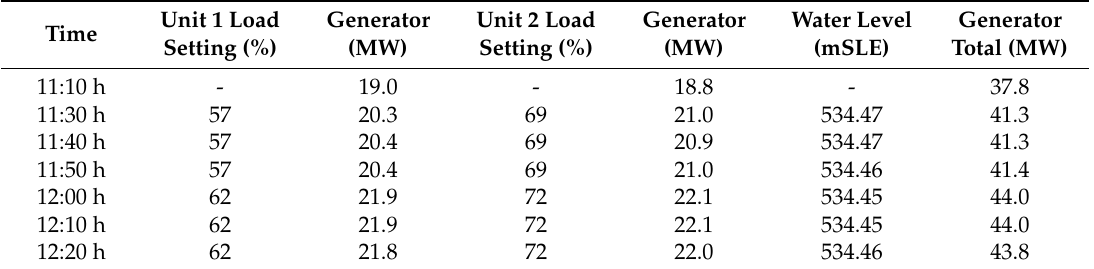
Table 4. Snapshots of controller raising the load to reduce spillages.